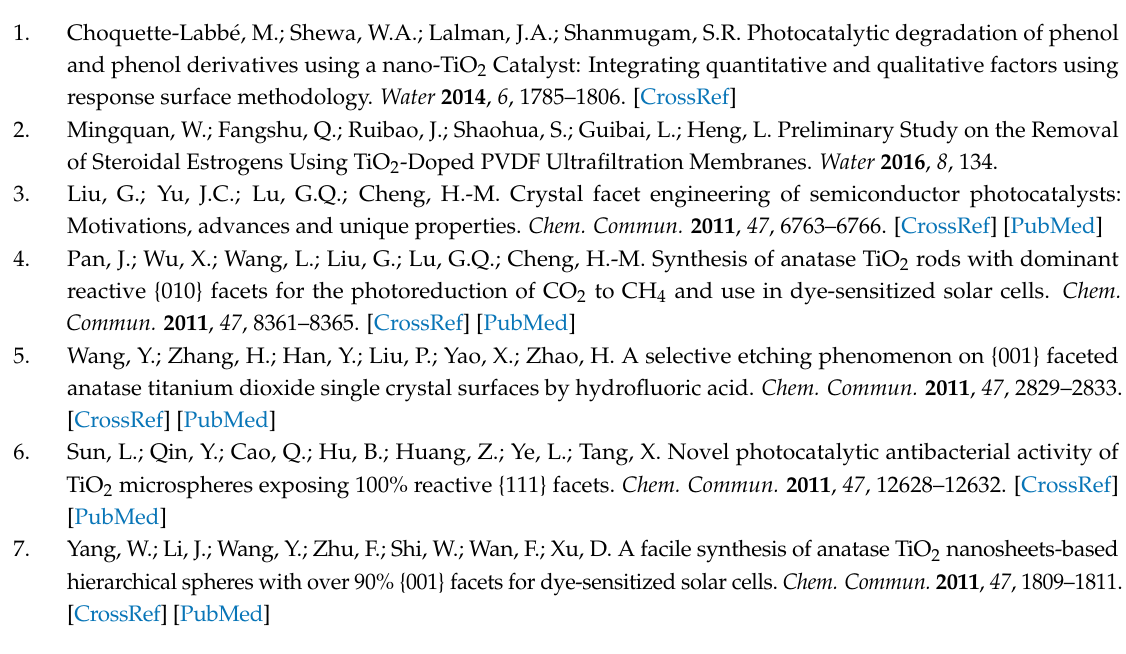
s1, Figure S1: UV-Vis absorption spectra of P25 and T-{010}, Figure S2: Images of suspension of (a) T-{010}, (b) P25 and (c) D. I. water, Figure S3: Zeta-potential of T-{010} and P25, Figure S4: Images of (a) P25, (b) T-{010}, (c) BP25 and (d) BT-{010}, Table S1: Summary of k app and normalized k app results, Figure S5: The diffuse reflectance UV-Vis spectra of colored TiO 2 , Figure S6: Wavelength-dependent apparent quantum yield for the photocatalytic degradation of ACE, Figure S7: Nyquist characterization of the